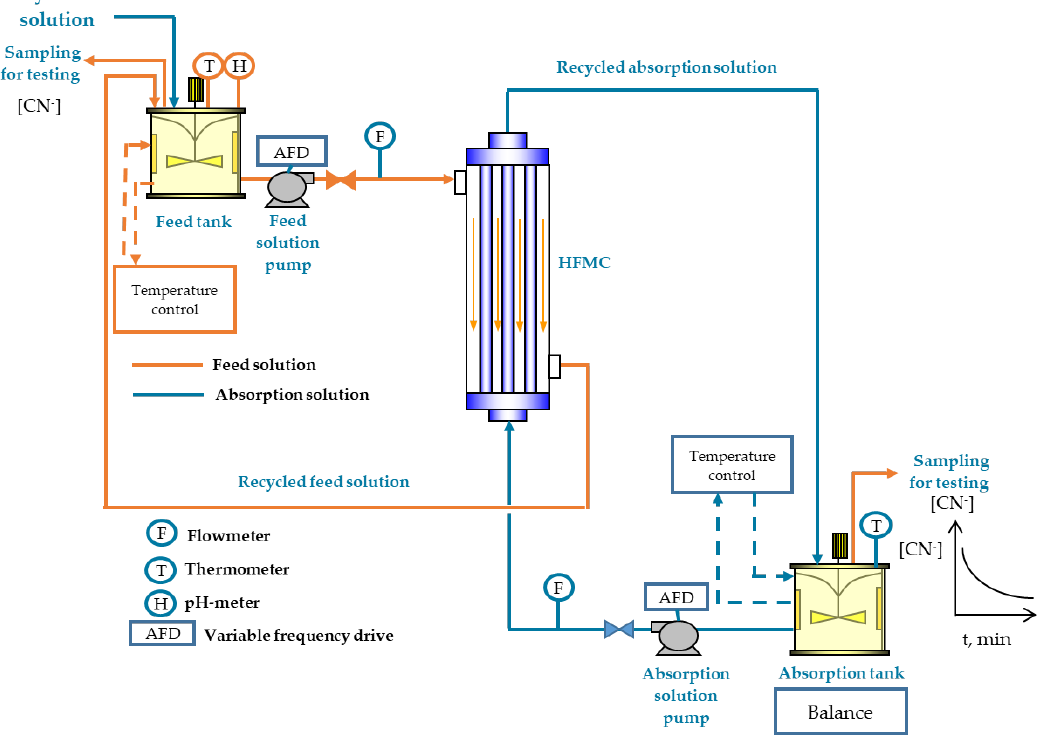
Figure 1. Laboratory scale experimental set-up for the gas-filled membrane absorption (GFMA) process.